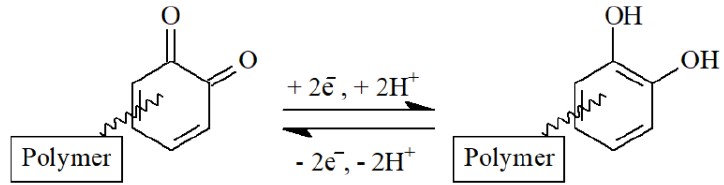
Scheme 7. Reduction of o -quinone fragments in the natural phenol-based polymer.